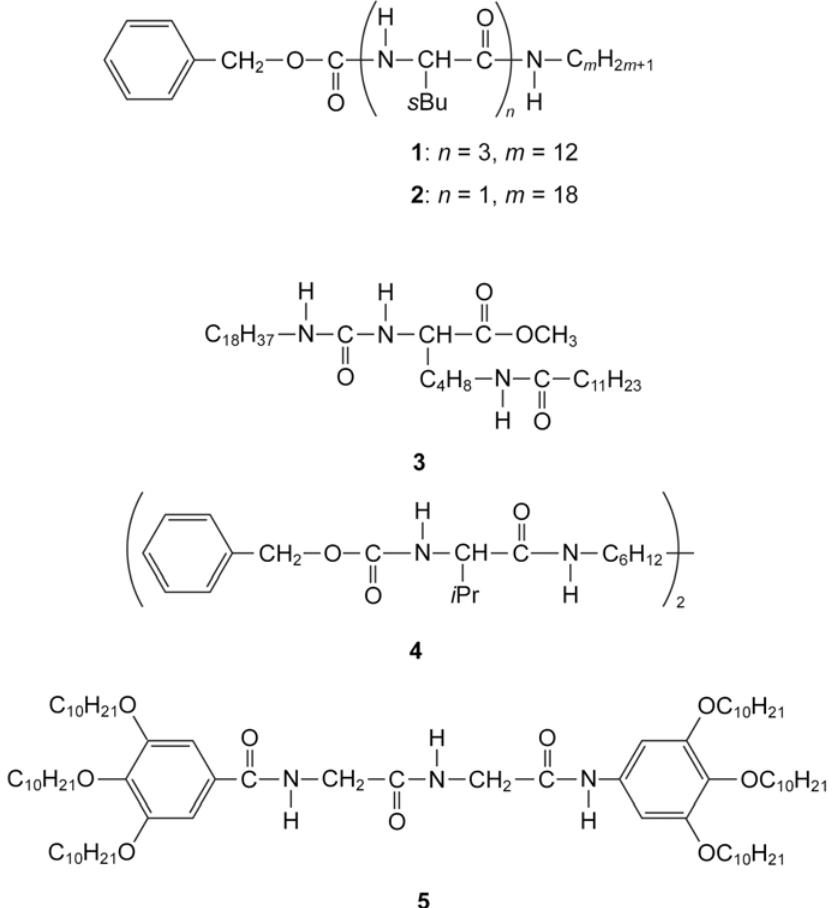
Figure 3. Chemical structures of